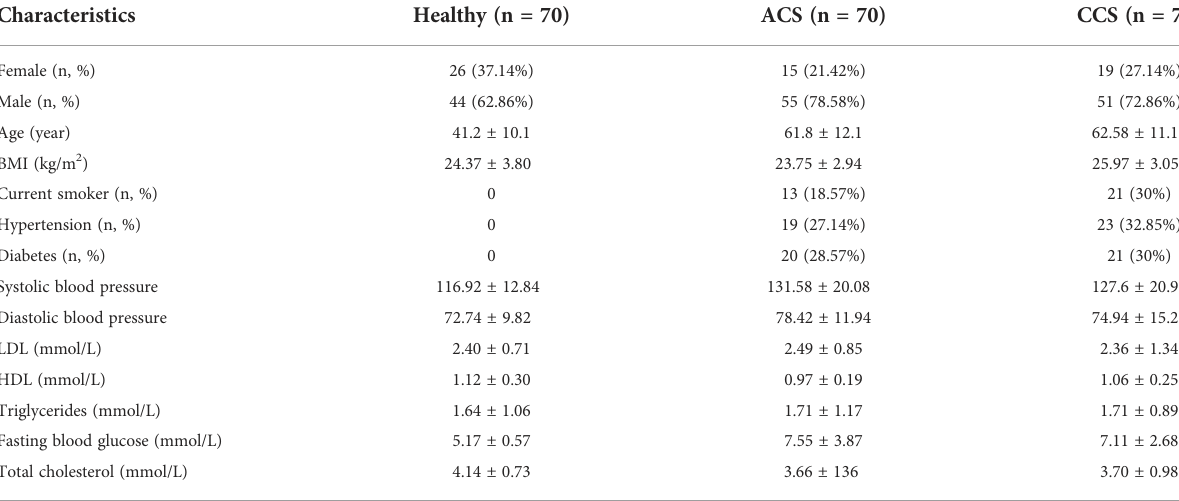
TABLE 1 Demographic and clinical characteristics of subject groups.